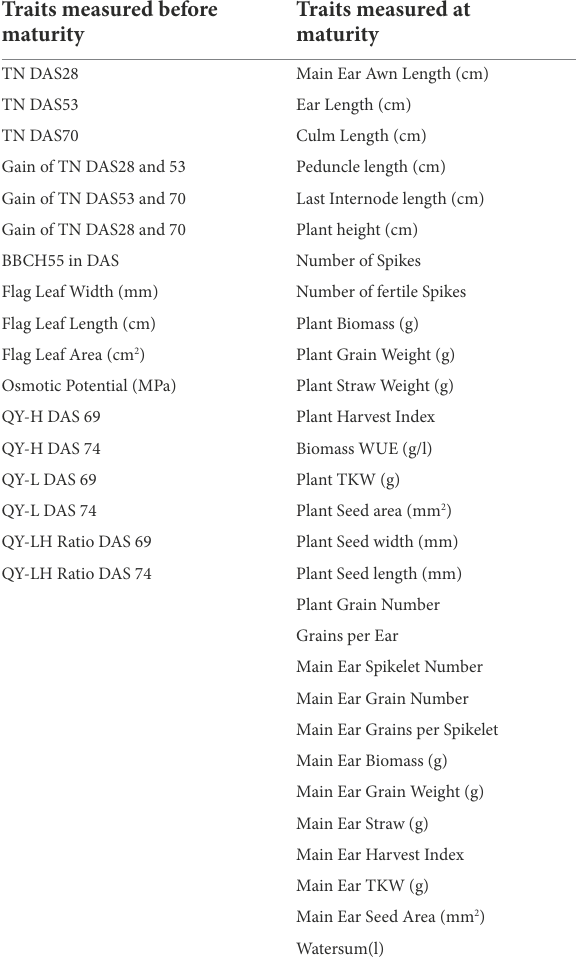
Traits measured at